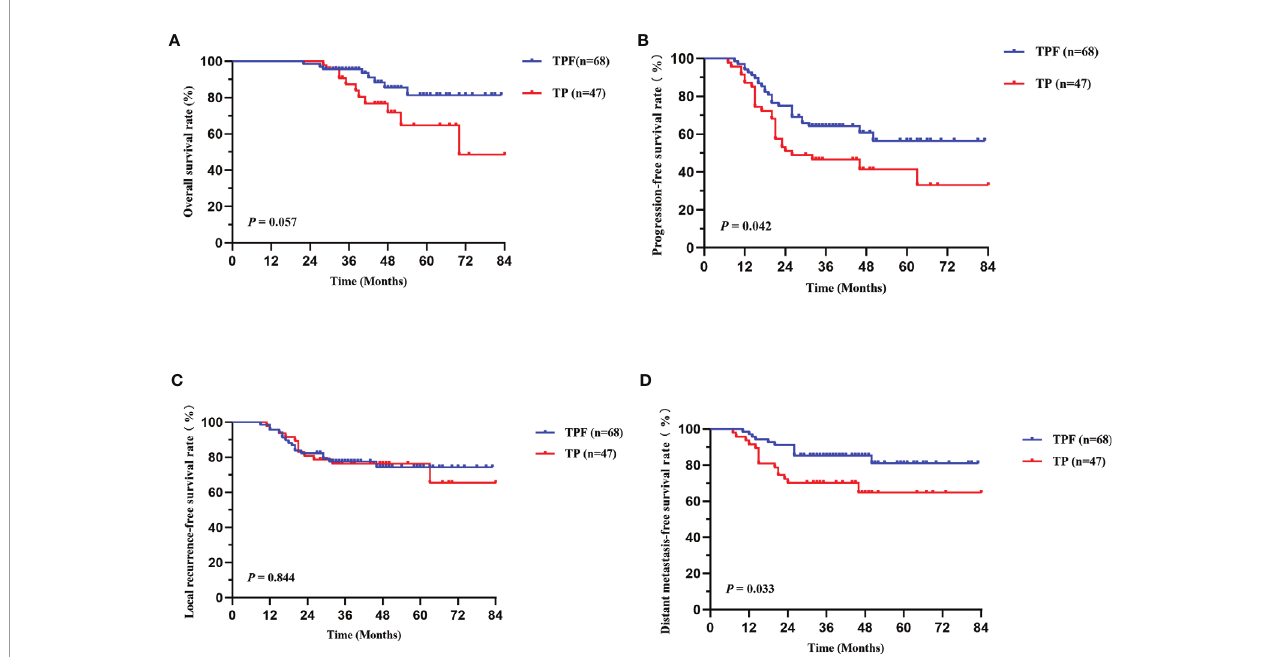
FIGURE 3 | Kaplan-Meier survival curves of OS (A) , PFS (B) , LRFS (C) , and DMFS (D) between TPF and TP groups in patients with stage IVA. TPF, docetaxel, cisplatin, and 5- fl uorouracil; TP, docetaxel and cisplatin; OS, overall survival; PFS, progression-free survival; LRFS, locoregional relapse-free survival; DMFS, distant metastasis-free survival.